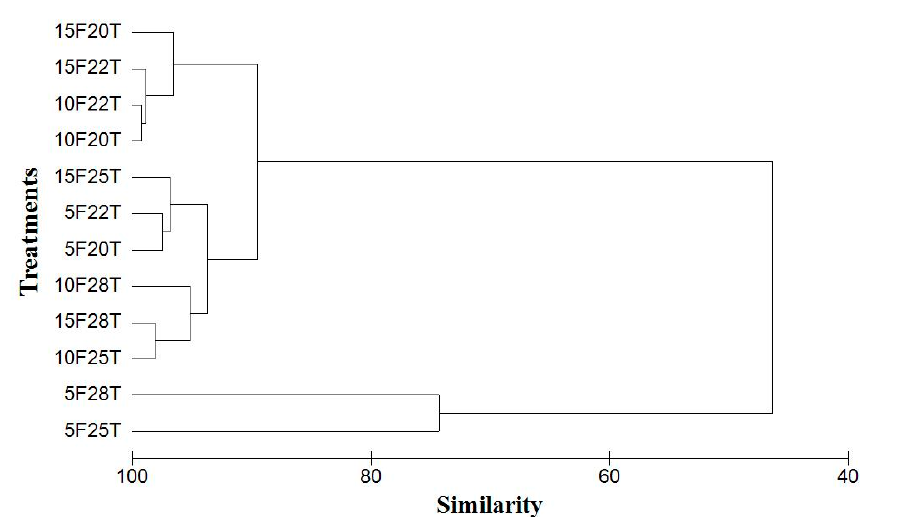
Figure 7. Cluster analysis of Acartia bifilosa population recruitment under different temperatures and food levels in the Jiaozhou Bay.